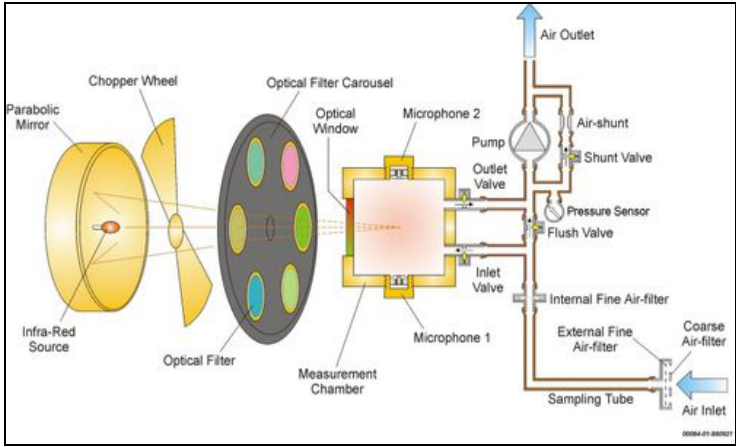
Figure 1. Photo Acoustic Spectroscopy detection principle [10].